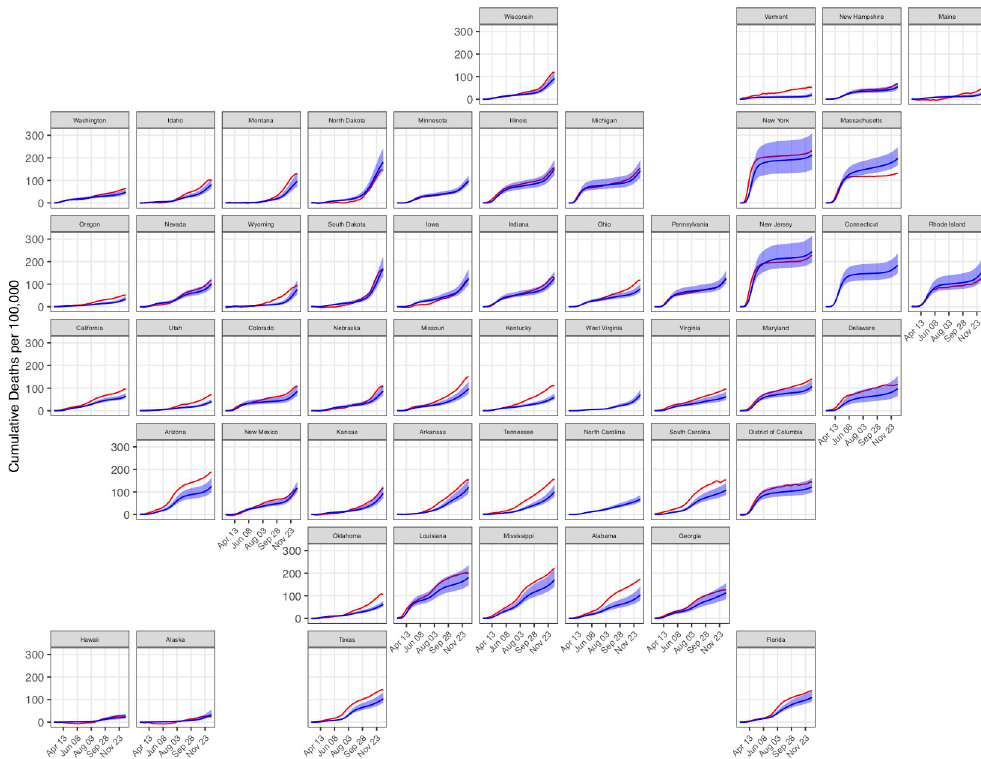
Fig 8. Comparison of cumulative COVID-19 deaths (blue) to cumulative excess all-cause mortality (red) for each US state from March 7 to December 19, 2020. Shaded areas represent 95% credible intervals.